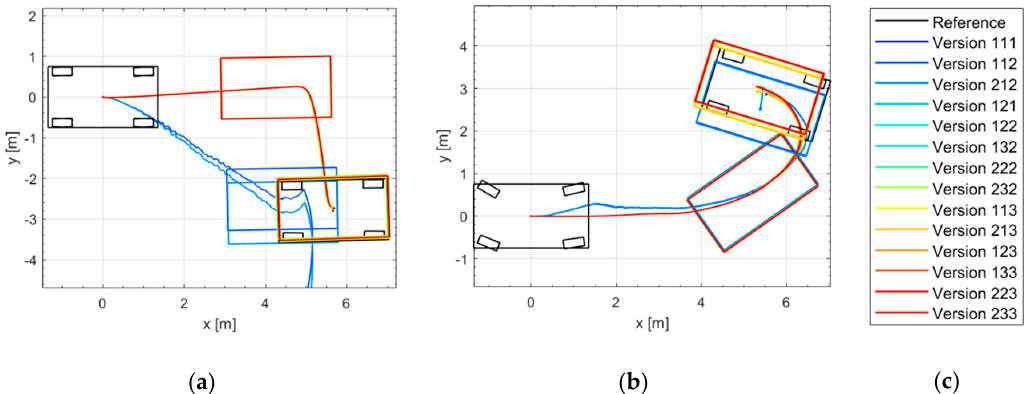
Figure 23. Real driving results of different odometry versions: ( a ) Trajectories in DM1; ( b ) Trajectories in DM3; ( c ) Legend.